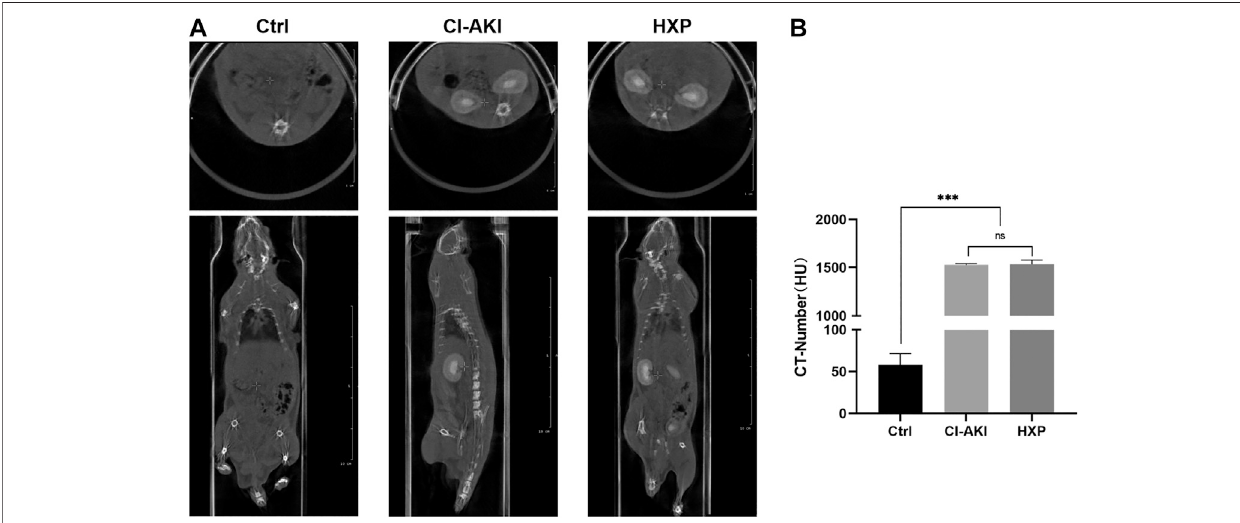
FIGURE 9 | The effect of XP on the imaging of iohexol (A) The enhanced CT images showed pronounced iodine exposure in the entire kidney after the injection of iohexol and plain CT scan in control rats at 200 s in the coronal plane and cross-section respectively. (B) The CT-number of three groups. Images presented are representative images. Data are presented as mean ± SEM ( n (cid:1) 2 in each group). ns p > 0.05; * p < 0.05; ** p < 0.01; *** p < 0.001 based on one-way analysis of variance. CVF, collagen volume fraction; Ctrl, control; CI-AKI, contrast induced-acute kidney injury; HXP, high dose XP combined with iohexol.